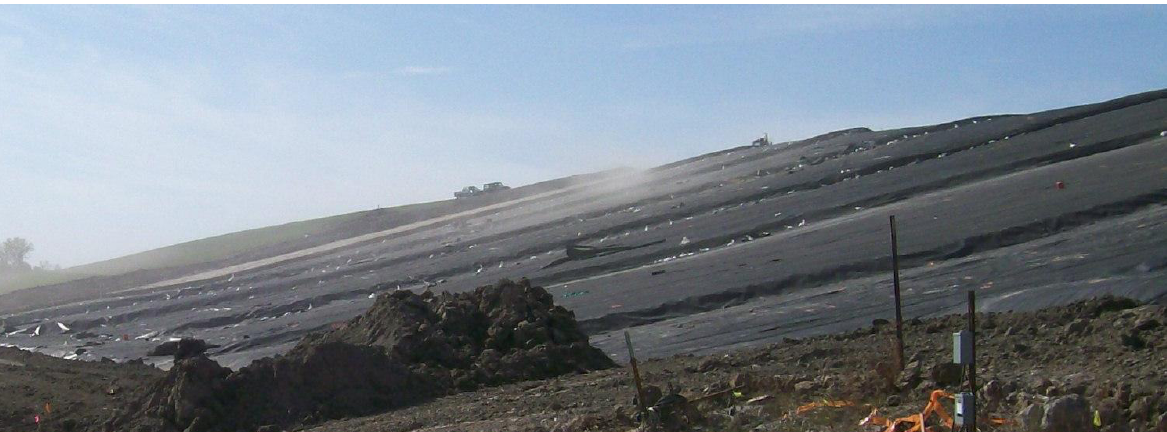
Figure 1. Photo of 1.0-mm thick HDPE exposed geomembrane cover. Soil windrows capped with geomembrane are visible in shadowed relief on the slope